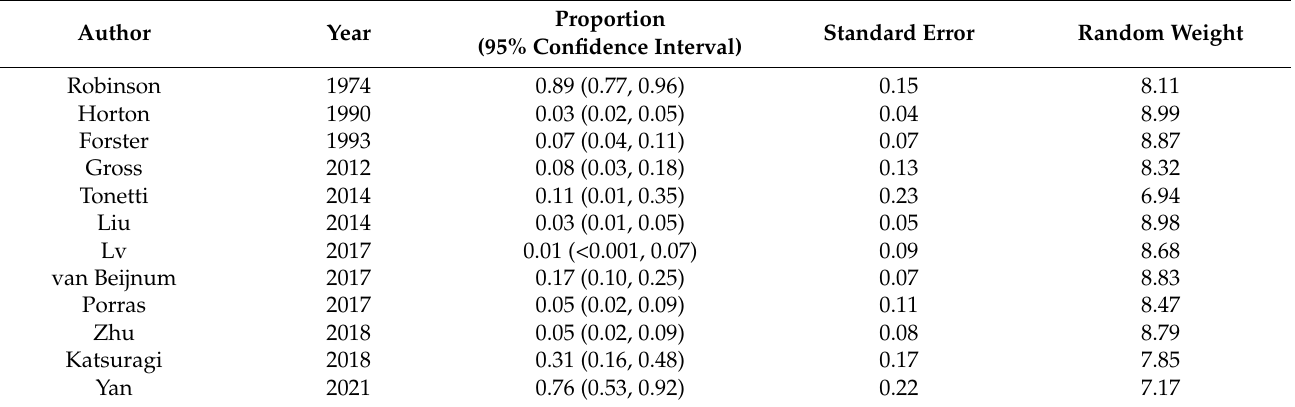
Table 3. The outcomes of individual study.